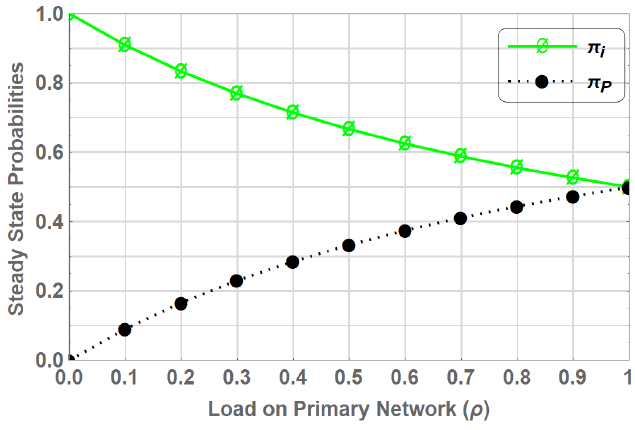
Figure 4. Stationary probabilities for PN-ONLY.